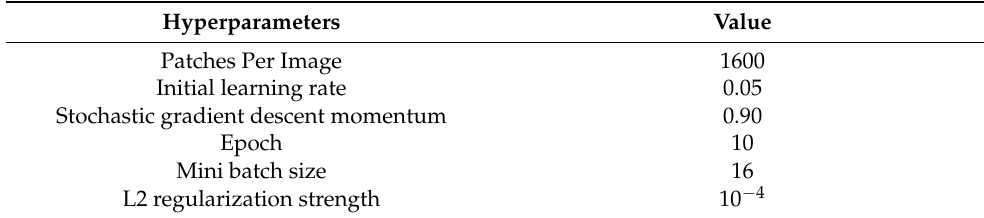
Table 4. Fixed hyperparameters and values for FCN-8s, DeepLabv3+Xception, and